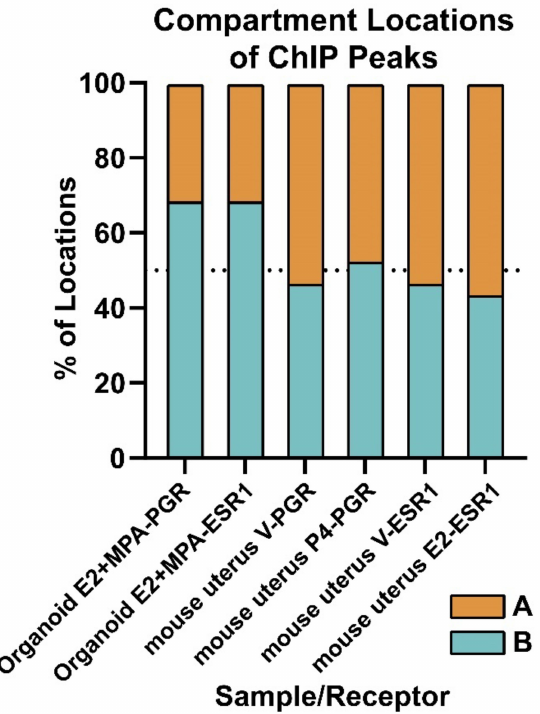
Figure 5. A higher proportion of organoid PGR and ESR1 ChIPseq peaks co-localize to B (inactive) compartment than is seen in mouse